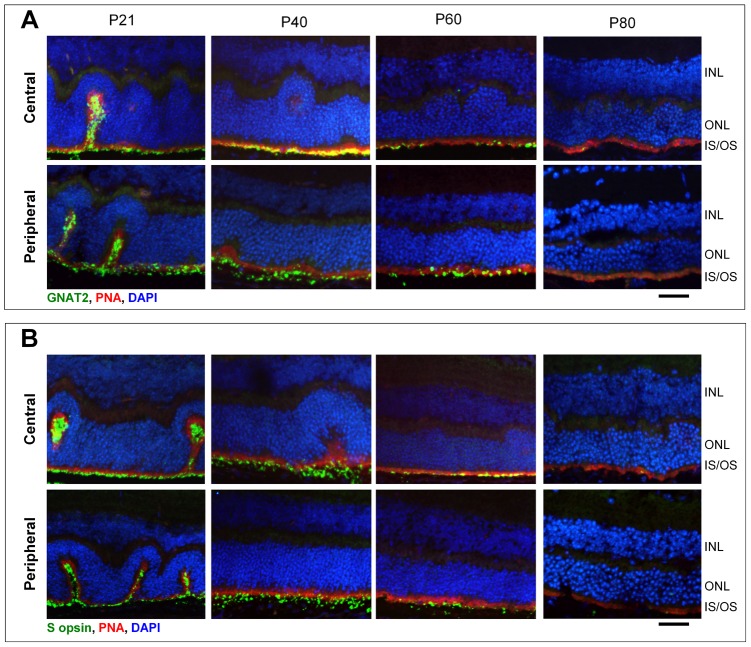
Expression of photoreceptor proteins is reduced over time in rd16;Nrl−/− mice.Representative cross sections (20X) from central and peripheral retina of P21, P40, P60 and P80 rd16;Nrl−/− mice were immunostained for the presence of cone transducin alpha (GNAT2) (A) or S- cone opsin (B) and PNA (A,B). Despite maintenance of cone outer segment sheaths (PNA), both GNAT2 and S-opsin expression are markedly reduced by P60 in both central and peripheral retina. INL- inner nuclear layer, ONL- outer nuclear layer, IS/OS- inner segments/outer segments. Calibration = 35 μm.